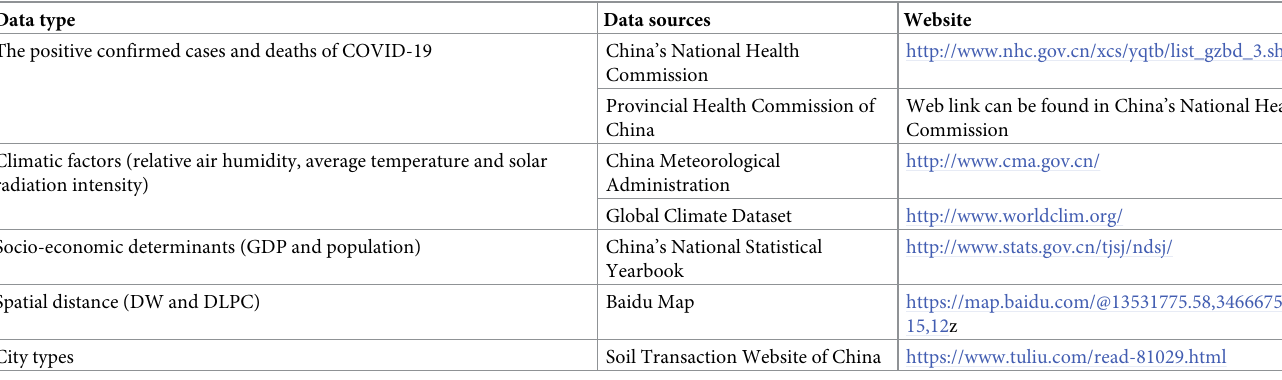
Table 1. A summary of data